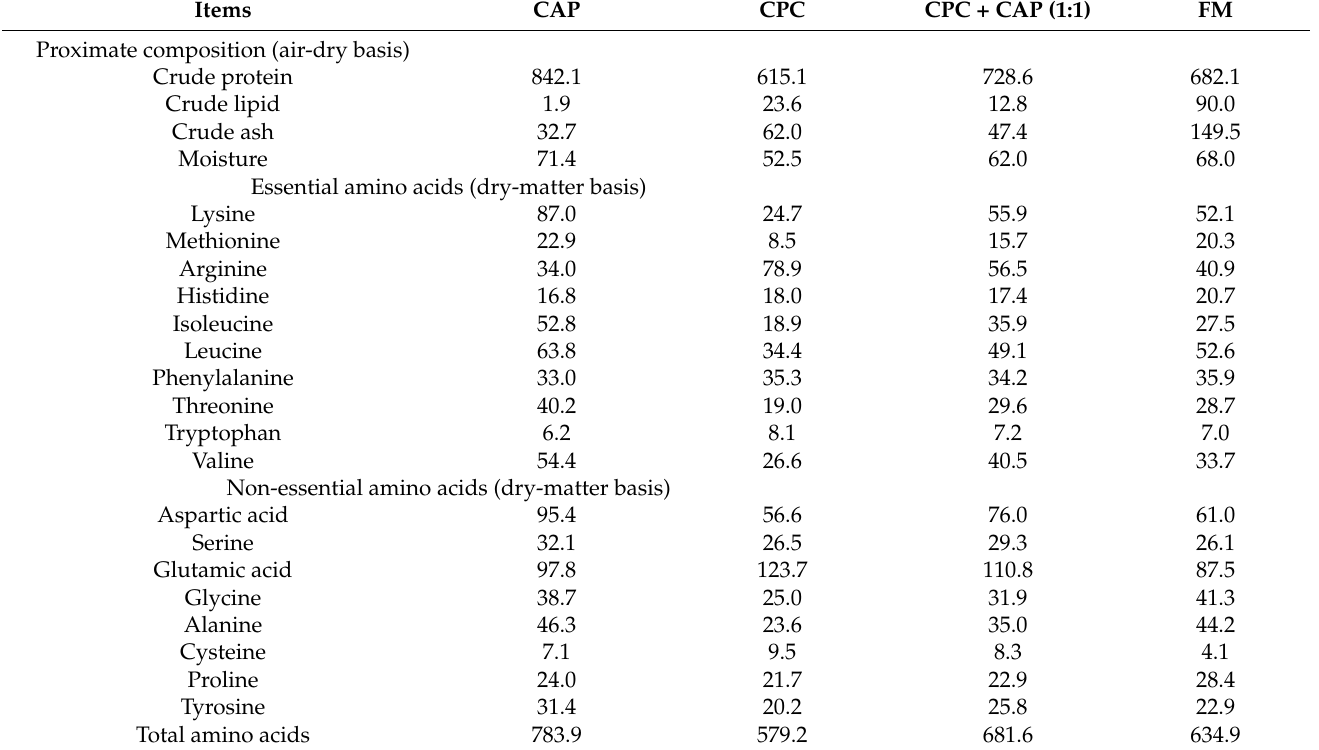
Table 2. The proximate composition and amino acid profile of the four ingredients